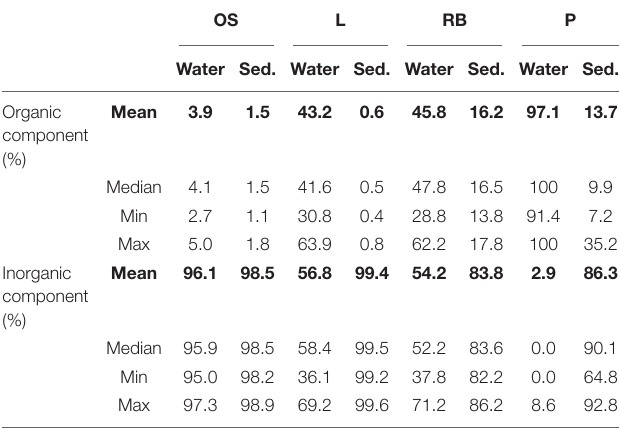
TABLE 2 | Percentage of the organic and inorganic fraction of suspended solids from water samples and lakebed sediment for environmental samples from Soda Lake (OS), Lake Neusiedl (L), the Reed Belt (RB), and the stabilization pond (P). OS L RB P Water Sed. Water Sed. Water Sed. Water